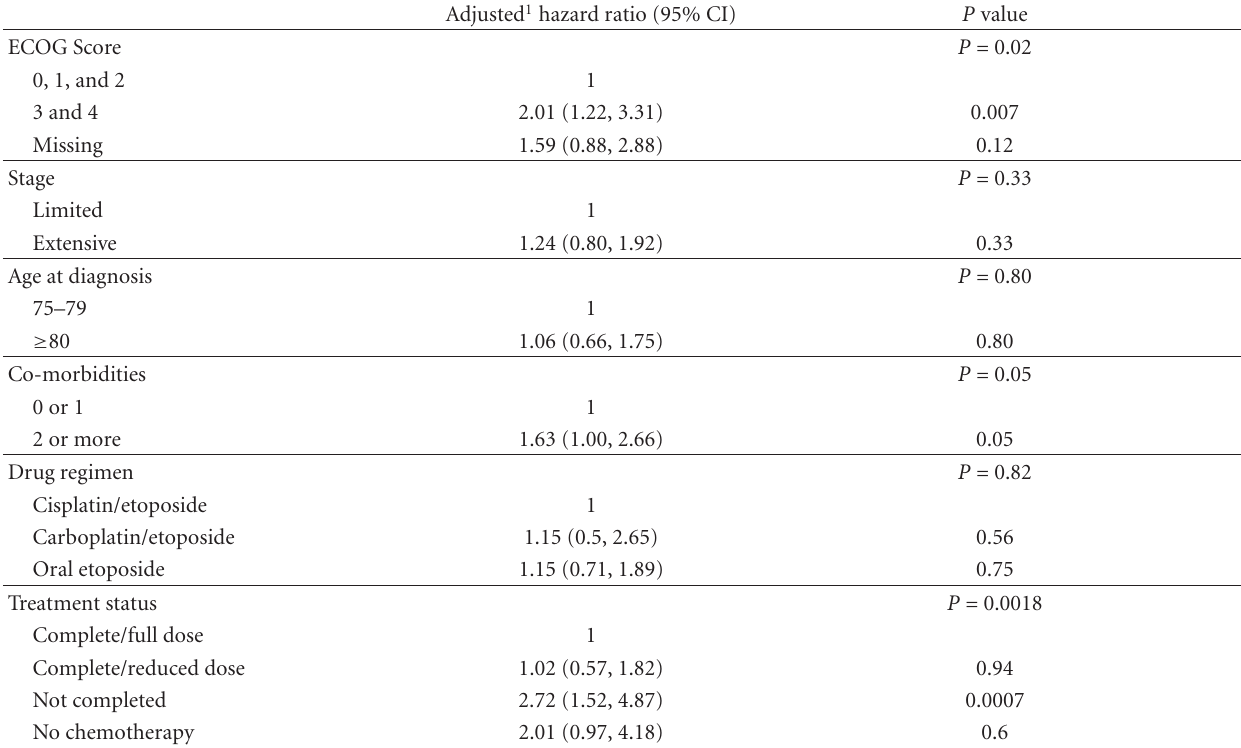
Table 6: Adjusted 1 hazard ratio of death of patients 75 years or older diagnosed with SCLC in 2004–2008 in Alberta, Canada, who had an oncologist-consult 2